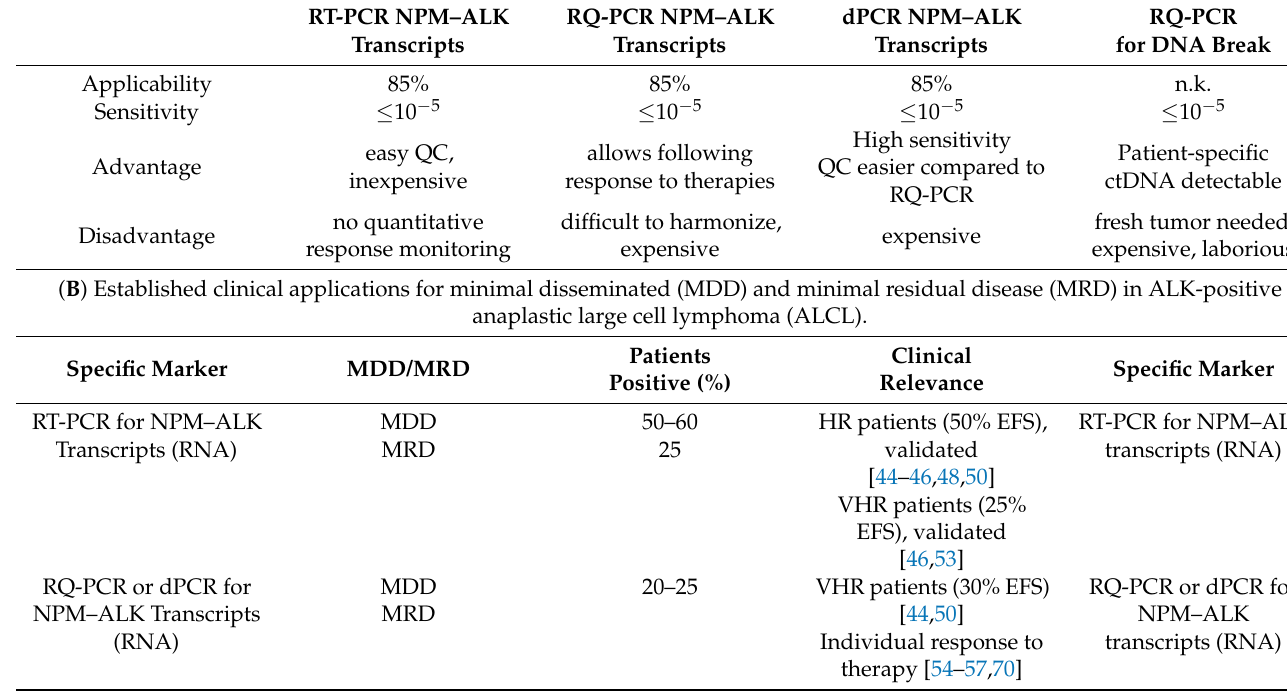
Table 2. Minimal disease detection for children with anaplastic large cell lymphoma (ALCL). ( A ) Methods to measure minimal disease in ALK-positive anaplastic large cell lymphoma